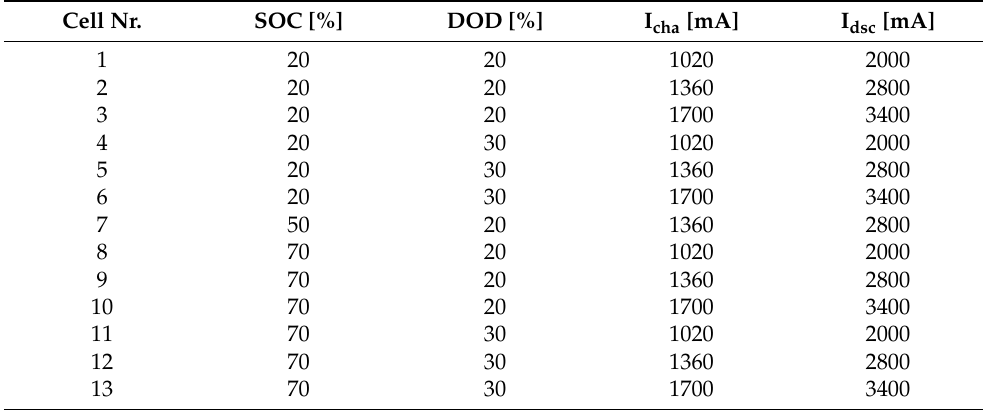
Table 2. Variation of test parameters for the cycling phase: DOD, average SOC, charge and discharge currents I cha and I dsc